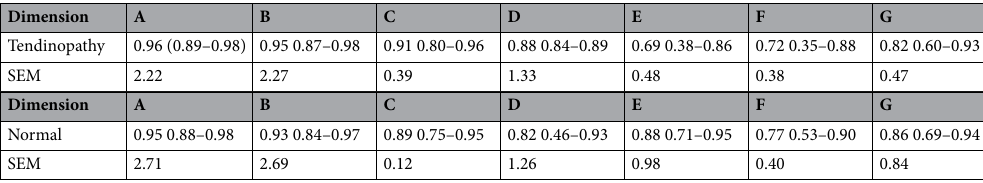
Table 1. ICC and SEM of the normal tendon and tendinopathy changed the Achilles tendon. A, B, C, D, E, F and G dimensions of the Achilles tendon defined in the Material and methods, ICC—interclass correlation coefficient, SEM—standard error of measurement.